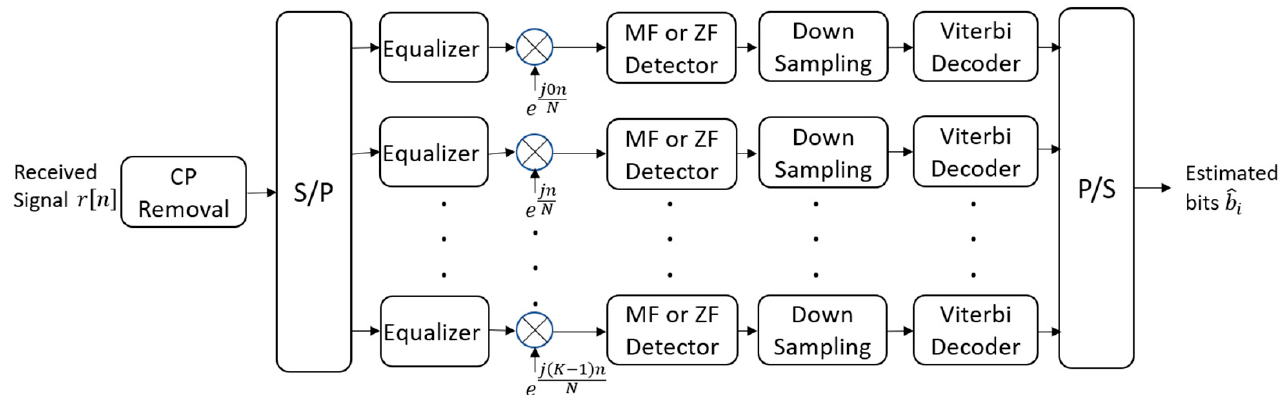
Figure 3. Proposed CPM-GFDM Receiver .